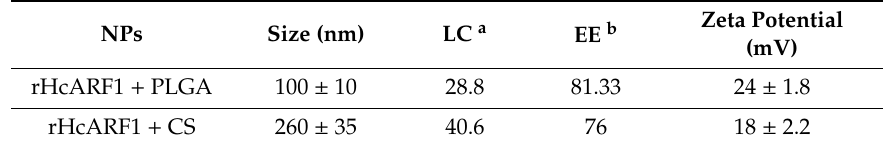
LC a = (total protein − unbound protein) / total dry weight of Nano-vaccine × 100%. EE b = (total protein − unbound protein) / total protein ×